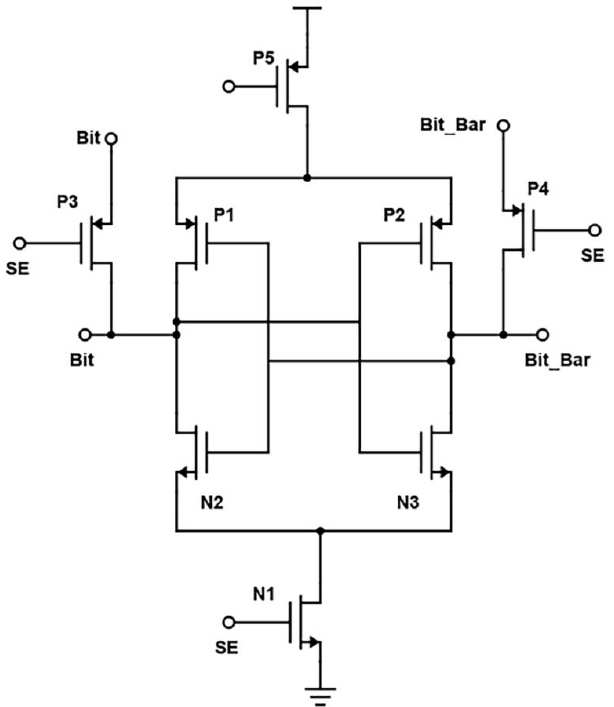
Figure 8. Basic Latched Sense Amplifier with Pass Transistor Schematic.